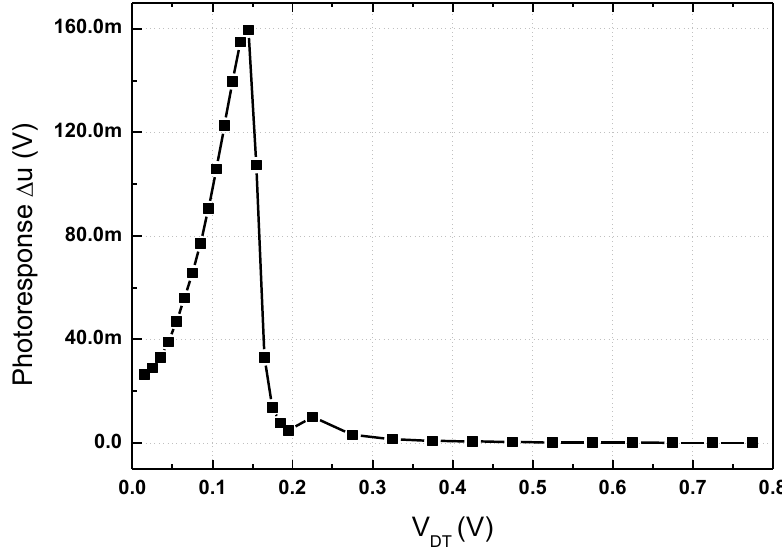
Figure 3. Simulated photoresponse at the output of the subthreshold preamplifier depending on the DC output voltage of the detector core. Table 1. The width and length of the transistors in the detector core and the preamplifier.